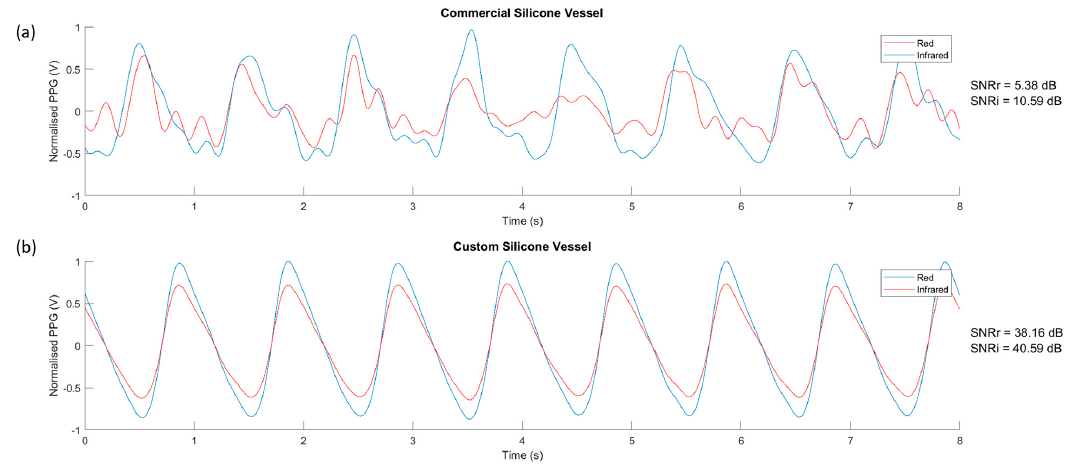
Figure 6. The photoplethysmography (PPG) signal from the clear vessel phantoms. ( a ) Commercial vessels. ( b ) Custom vessels. SNRr = signal-to-noise ratio (red wavelength). SNRi = signal-to-noise ratio (infrared wavelength).